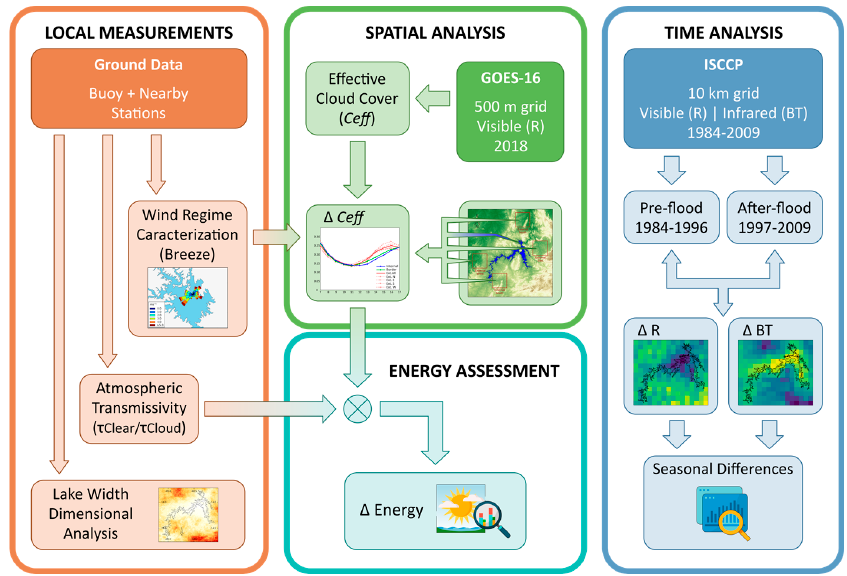
Figure 2. Flowchart of the three strategies used in this study to characterize the lake breeze: in situ measurements (5 years), a high-resolution short-term satellite dataset (one year), and a low-resolution long-term satellite dataset (29 years).